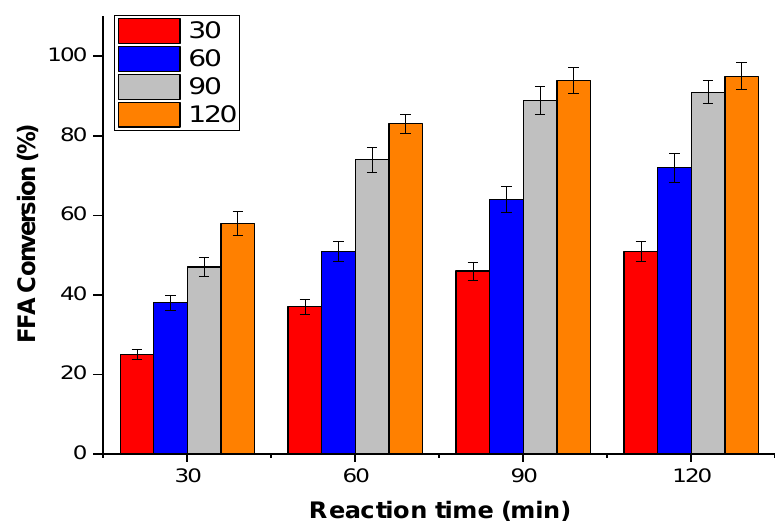
Figure 8. E ff ect of reaction time on FFA Figure 8. Effect of reaction time on FFA conversion.